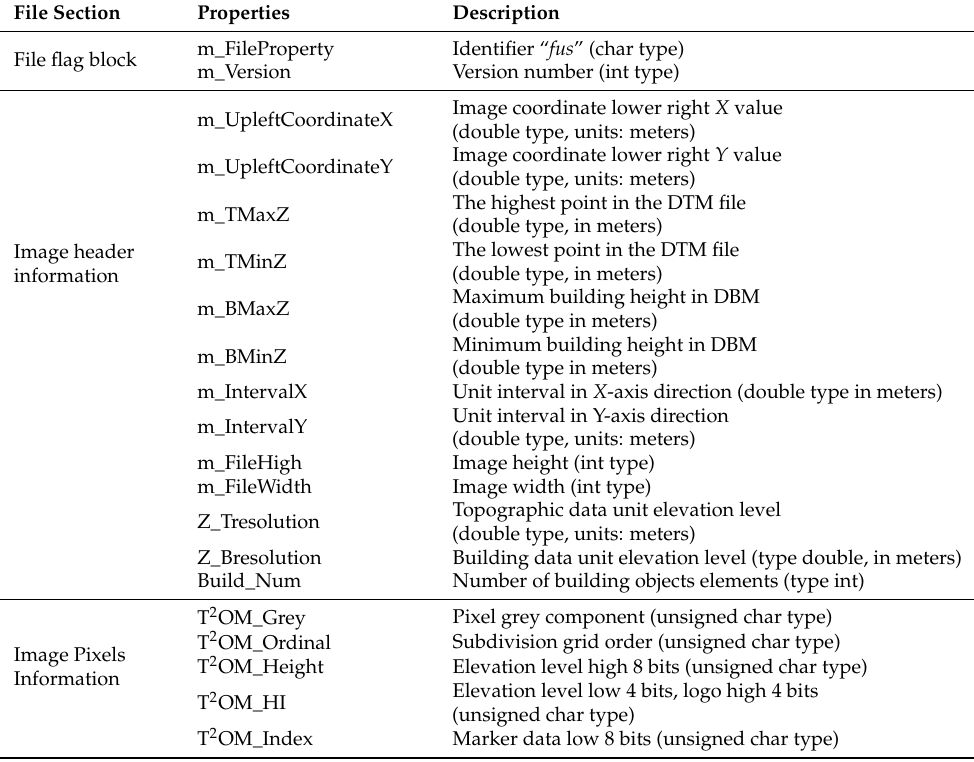
Table 11. The file format of the T 2 OM fus